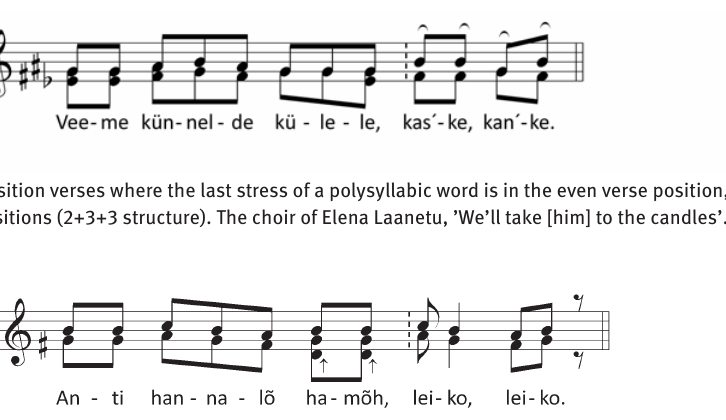
Figure 3: 7-position verses with a three-position stress group in the centre (2+3+2 structure). The choir of Aleksandra Tamm, ’The shirt was given for the tail’.